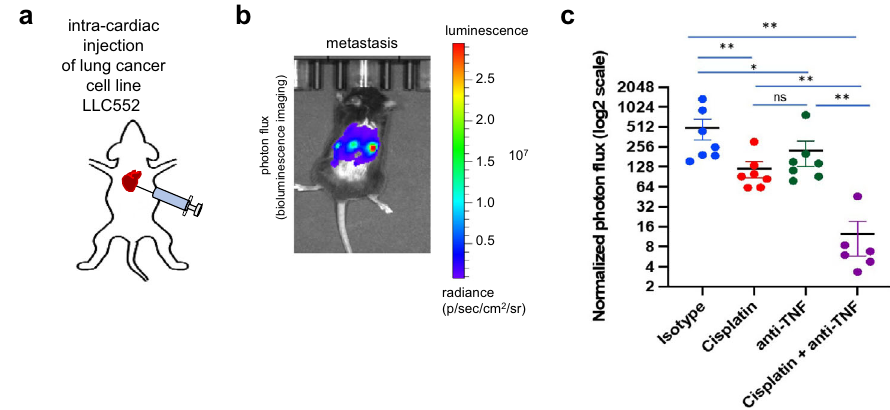
Fig. 1 | Anti-TNF- α antibodies enhance the anti-metastatic effect of cisplatin. a Schematic of intra-cardiac (i.c.) injections and development of metastasis in the murineLLClivermetastasislung cancermodel. b Atotalof1×10 5 murine LLC-liver met cells were injected into the arterial circulation via i.c. injection in 8-to-9-week- old syngeneic C57BL/6 male mice, which gradually developed metastasis to the liver, lymph nodes and chest cavity, as con fi rmed by bioluminescence imaging on